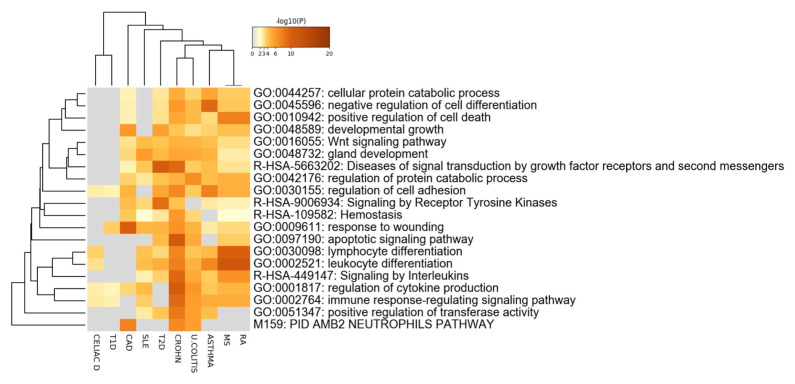
COVID-19 meta-interactome pathway analysis.Heatmap of top 20 enriched terms across input gene lists, colored by p-values. MS: Multiple Sclerosis; RA: Rheumatoid Arthritis; SLE: Systemic Lupus Erythematosus; CROHN: Crohn’s Disease. U. COLITIS: Ulcerative Colitis; CELIAC D.: Celiac Disease; T1D: Type 1 Diabetes Mellitus; T2D: Type 2 Diabetes Mellitus; CAD: Coronary Artery Disease.